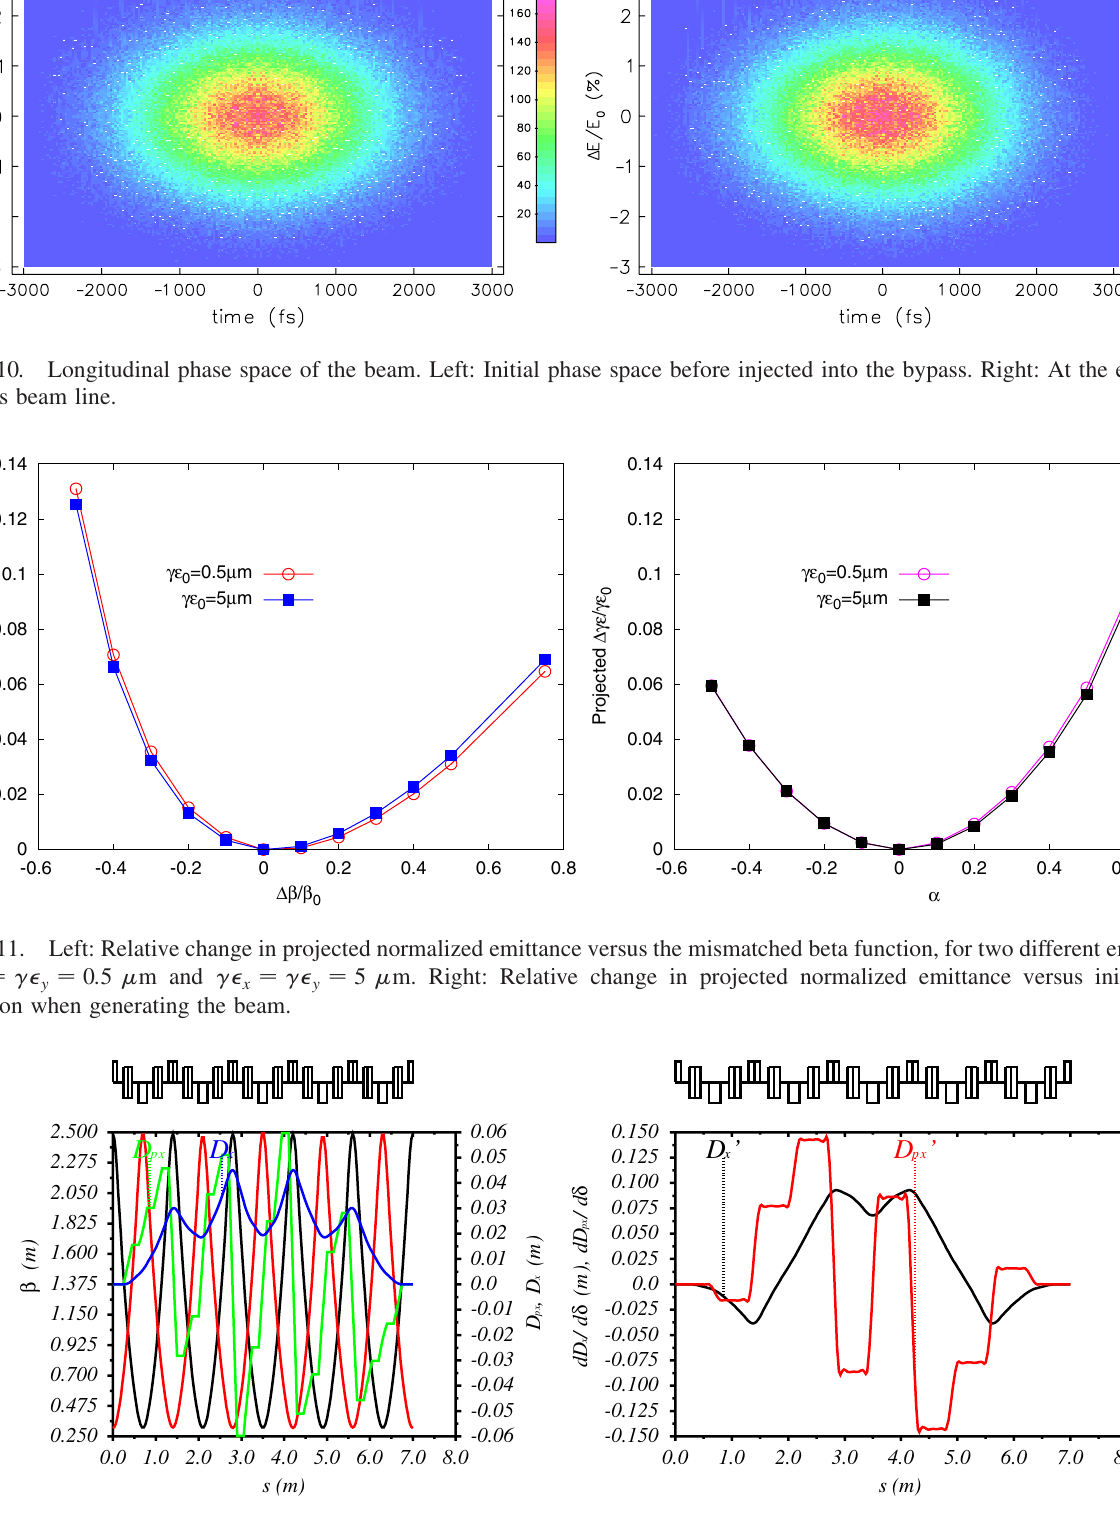
FIG. 12. First order and second-order optics of a supercell composed of five FODO cells. The horizontal and vertical betatron phase advances are both 90 (cid:5) . The four dipole magnets at each end have a bending angle which is roughly a half of the two central dipoles. The dipole strength and phase advance are slightly tuned to generate a second-order achromat. Left: First order dispersion and beta functions. Right: Second-order dispersion T 166 and angular dispersion T 266